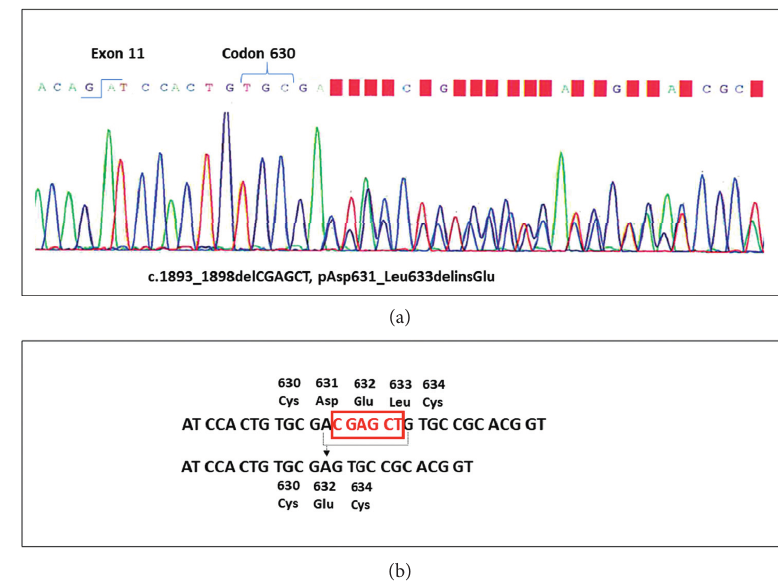
Figure 3: The RET germline deletion in exon 11 of our patient. (a) Sanger sequence analysis of the constitutive DNA showing the heterozygous germline deletion of 6 nucleotides (C GAG CT) that determined an “in frame” deletion of the RET gene at the level of codons 631–633 in exon 11. (b) The deletion involved the third nucleotide (i.e., C nucleotide) of codon 631, the entire codon 632, and the first two nucleotides of codon 633 (i.e., C and Tnucleotides). With this deletion, codon 631 returned in frame with the third nucleotide of codon 633 (G nucleotide), changing codon 631 from aspartate (Asp) to glutamic acid